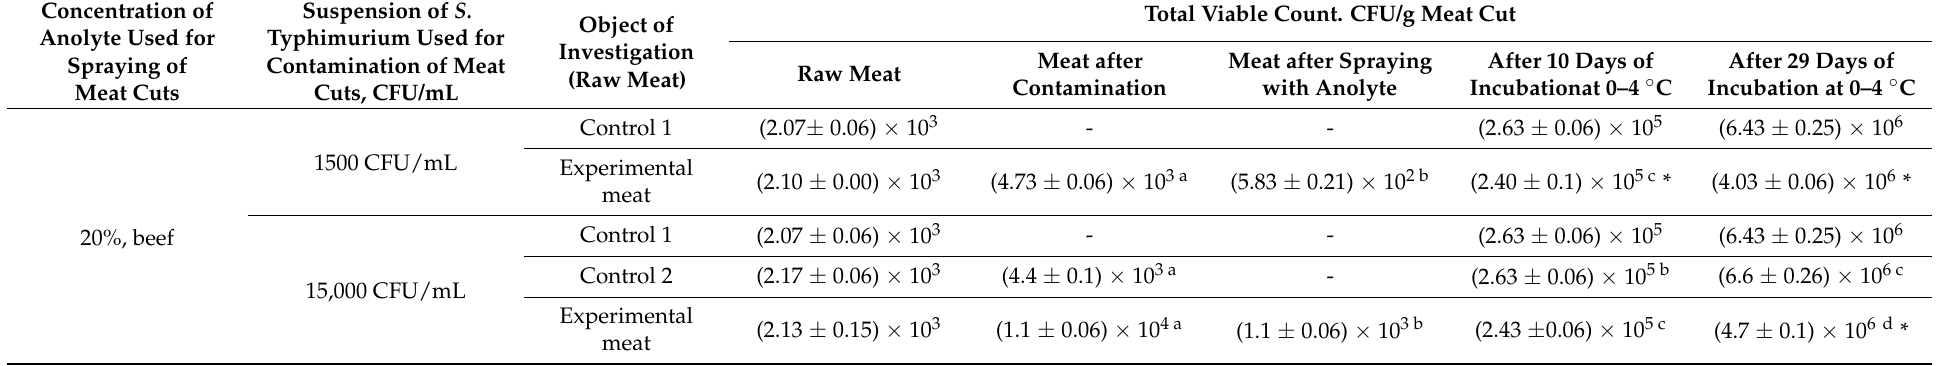
Table 3. The effect of anolyte’s concentration on the total viable count of meat cuts contaminated with S. Typhimurium. Concentration of Suspension of S. Anolyte Used for Spraying of Meat Cuts